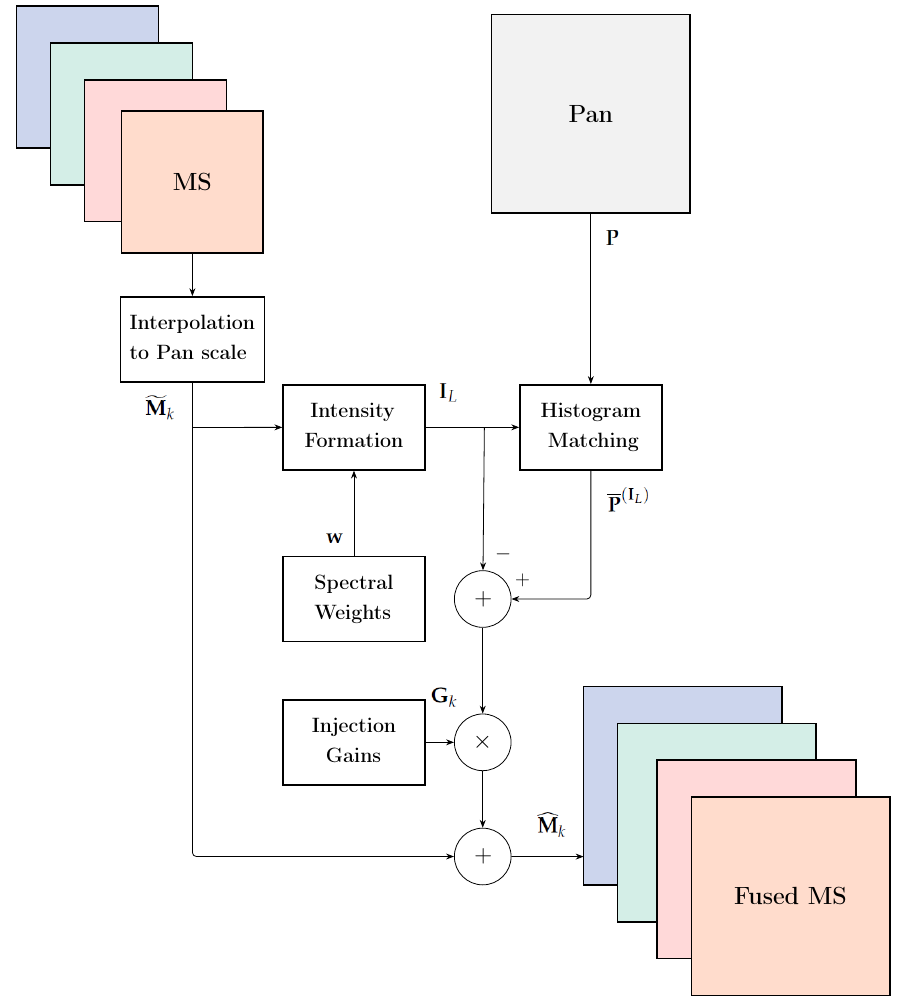
Figure 2. Flowchart of a general fusion method belonging to the CS